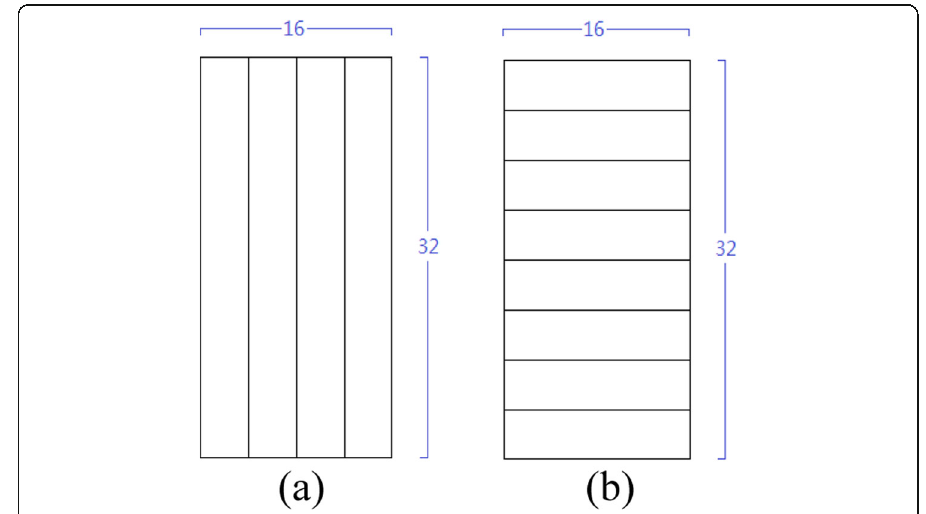
Fig. 3 Feature extraction for digit recognition: a four column regions and b eight row